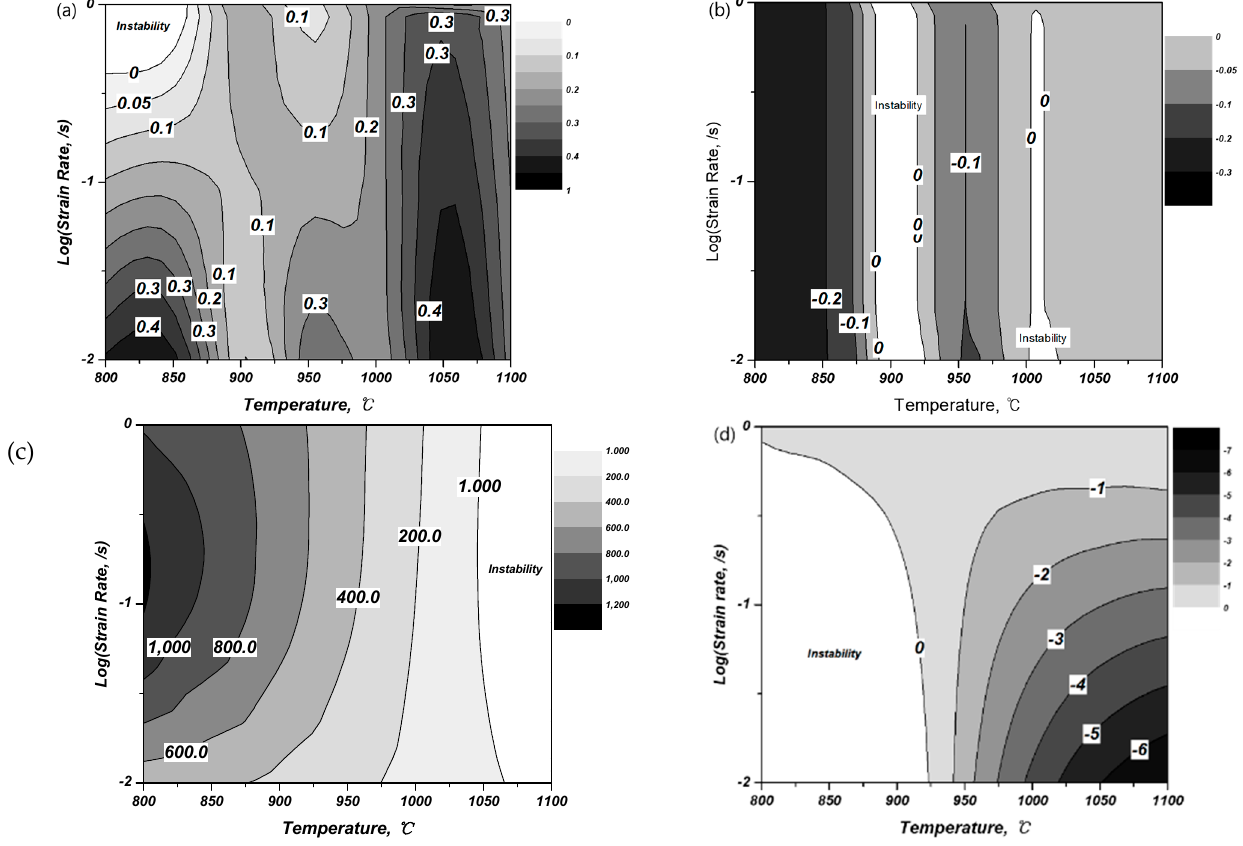
Figure 10. Deformation contour map shown by temperature-log(strain rate) relation of Ti-6Al-4V alloy ( ε = 0.6) by Malas’s instability criterion ( ξ ); ( a ) strain rate sensitivity (m), ( b ) m ′ , ( c ) deformation temperature sensitivity (s), ( d ) s’.